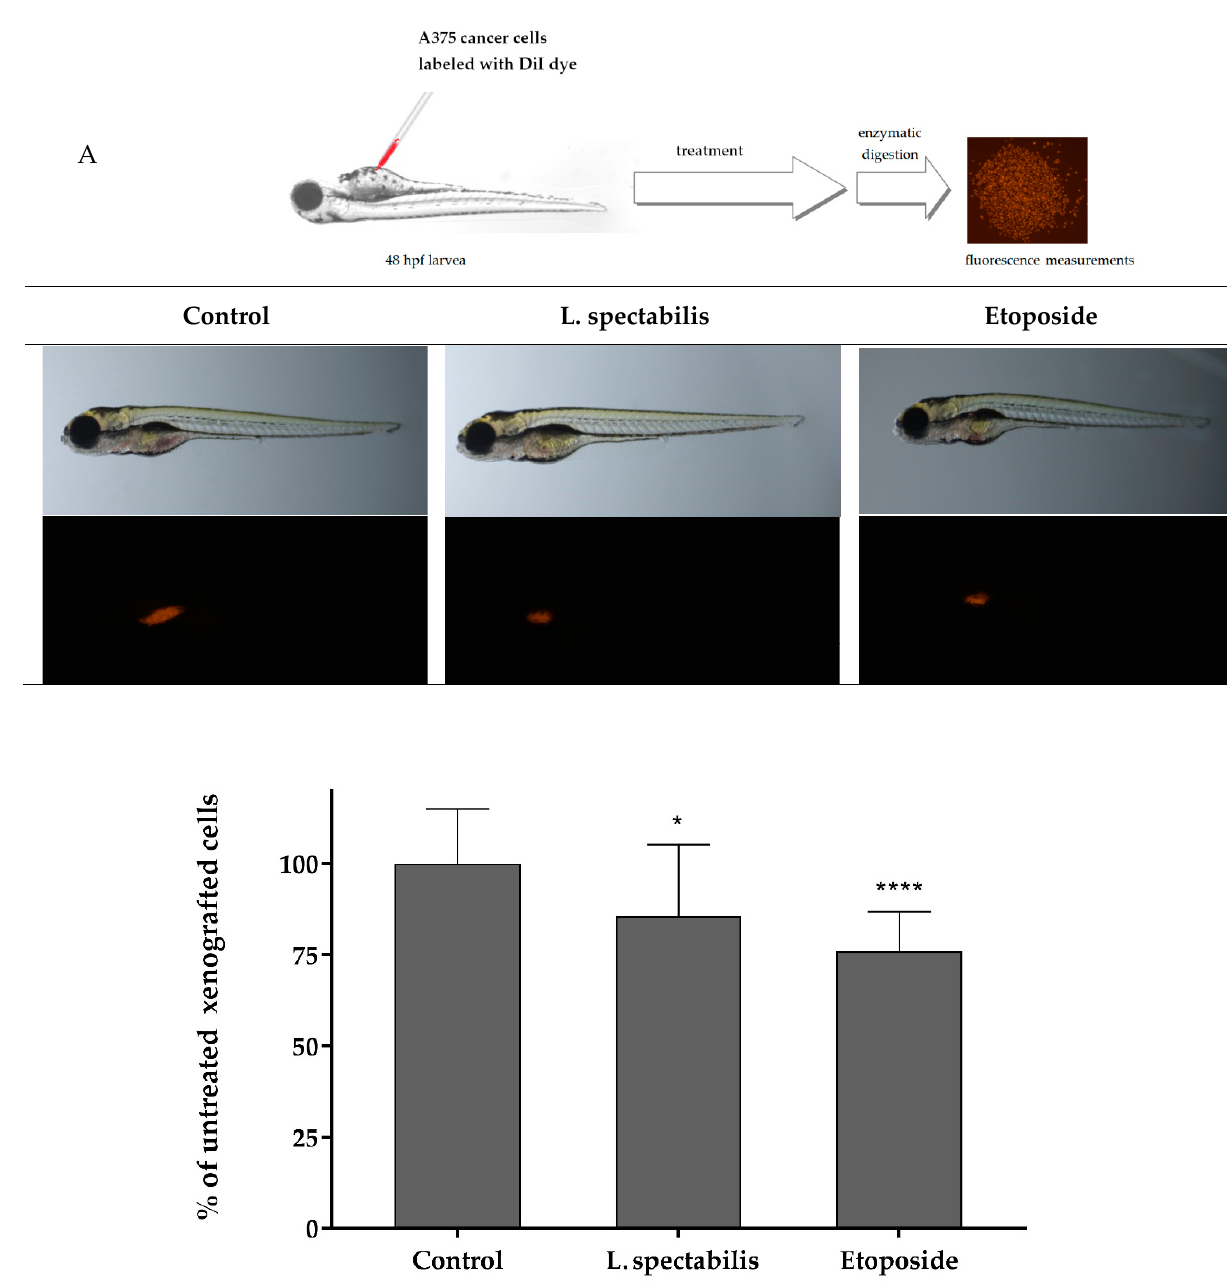
Figure 5. Antitumor activity of Lamprocapnos spectabilis extract in vivo. ( A ) Schematic diagram of the experiment based on the zebrafish human tumor xenograft model. ( B ) Images of 96 hpf (hours post fertilization)/48 hpi (hours post injection) larvae. Zebrafish larvae were xenografted with A375 cells (an average of 500 cells) and treated with 7.5 µ g/mL of Lamprocapnos spectabilis extract or 5 µ g/mL of a reference drug—etoposide or fish medium E3—as a control (10 animals/group). ( C ) Inhibition of cancer cell proliferation in vivo. * p < 0.05 (vs. control group; one-way ANOVA), **** p < 0.0001 (vs. control group; one-way ANOVA).